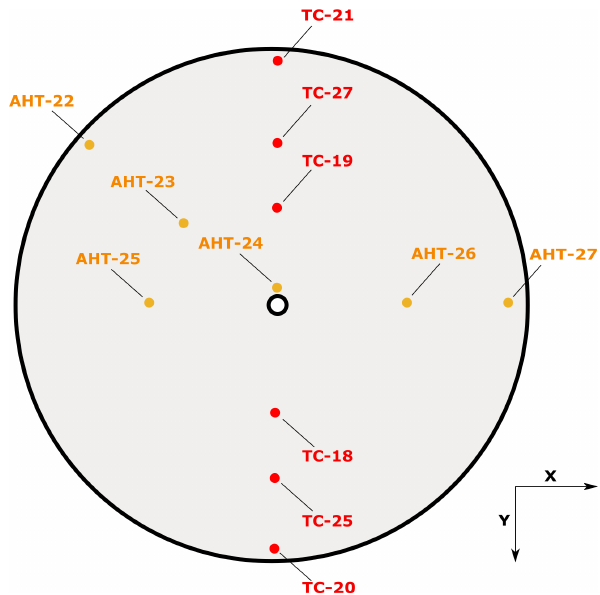
Figure 2. A schematic illustration of the Aeolus M1 mirror. The red and orange dots indicate the positions of the thermal control (TC) and accurate housekeeping (AHT) thermistors. X indicates the flight direction. Note that TC-23, TC-29 and TC-32 are not